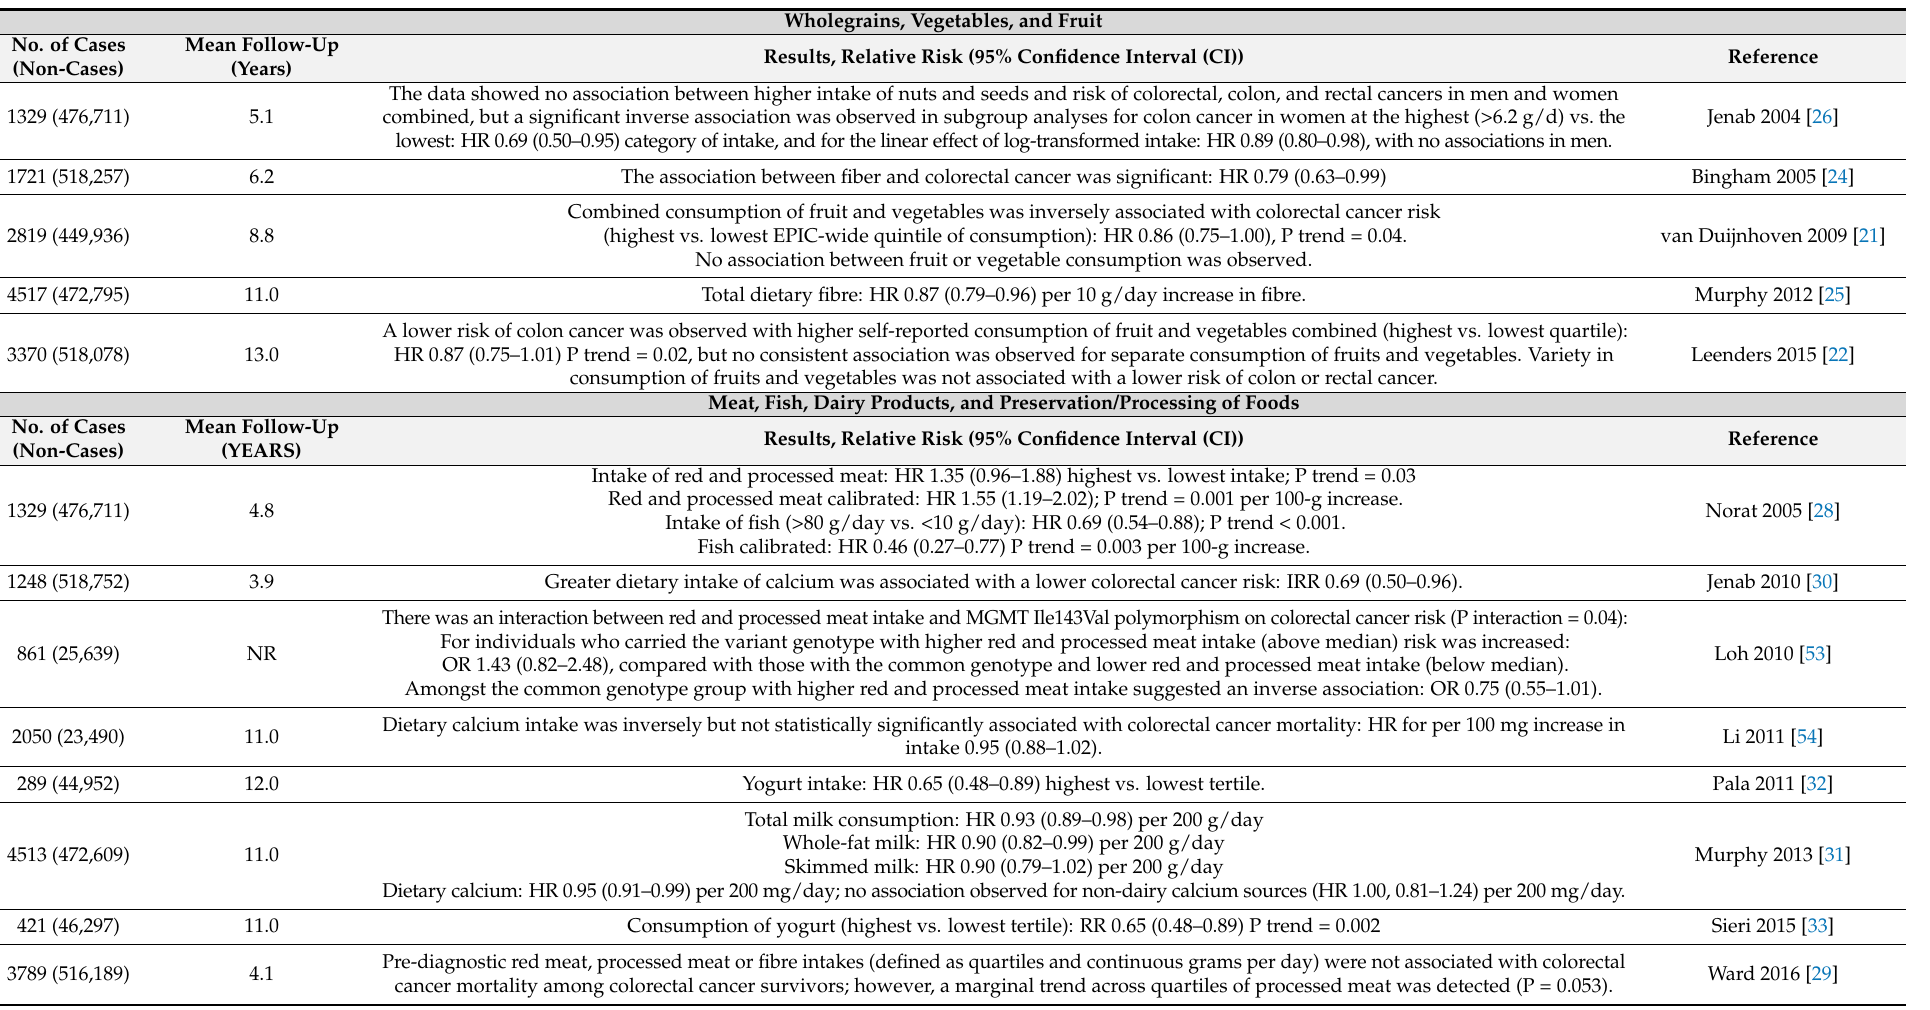
Table 1. Evidence synthesis of the association between diet and colorectal cancer in the EPIC study. Wholegrains, Vegetables, and Fruit No. of